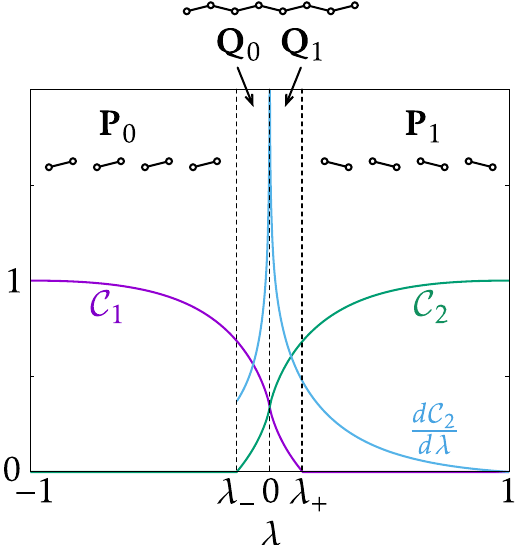
Figure 2. Phase diagram of many-body entanglement in the thermodynamic limit. There exist four phases P {0,1} and Q {0,1} with transition points λ 0 = 0 and λ ± . ±  0 138 . The corresponding entangled graphs are depicted in the